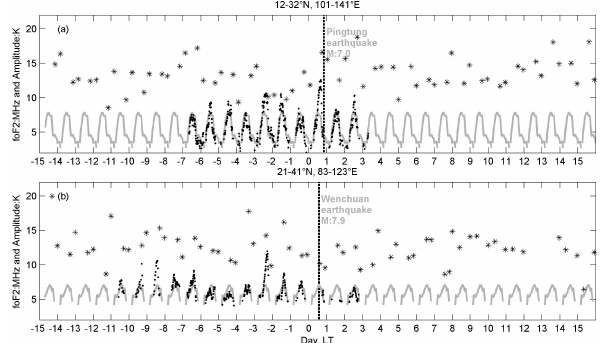
Fig. 9. The comparison of the foF2 and the intensity of the internal gravity wave with the wavelength of 20–30km at 80–120km in al- titude for the Pingtung Doublet and Wenchuan earthquakes during 15 days before and after the earthquakes. The square area studied are 12–32 ◦ N, 101–141 ◦ E, and 21–41 ◦ N, 83–123 ◦ E for the Ping- tung Doublet and Wenchuan earthquakes, respectively. The gray lines are the hourly average foF2 of the 14 days observation for the Wuhan ionosonde station and 10 days observation for the Pingtung ionosonde station, respectively. The dark stars indicate the intensity of internal gravity waves within the wavelength range of 20–30km. The vertical dotted black lines denote the time of occurrences of the two